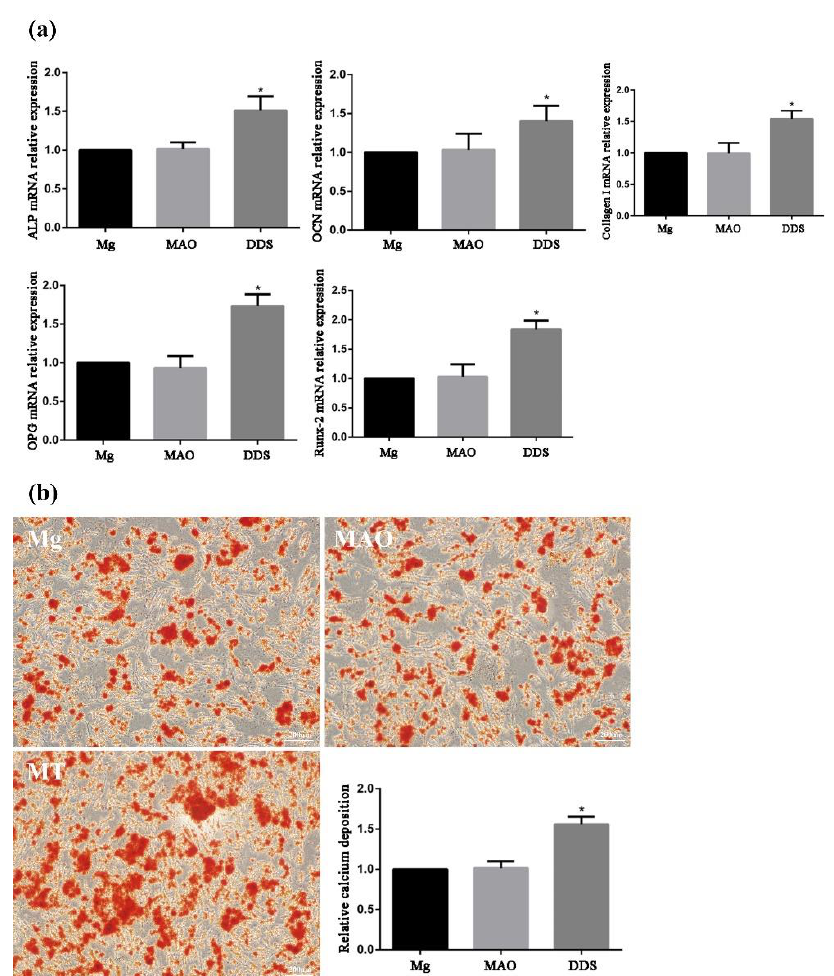
Figure 10. The mRNA relative expression of ALP, collagen I, OCN, OPG, and Runx-2 ( a ) by PCR tests and the relative calcium deposition by alizarin red staining ( b ) of Mg alloy, Mg-based-MAO alloy, and Mg-based MAO-MT-PLGA DDS. “*” represents the DDS group compared with the control groups.